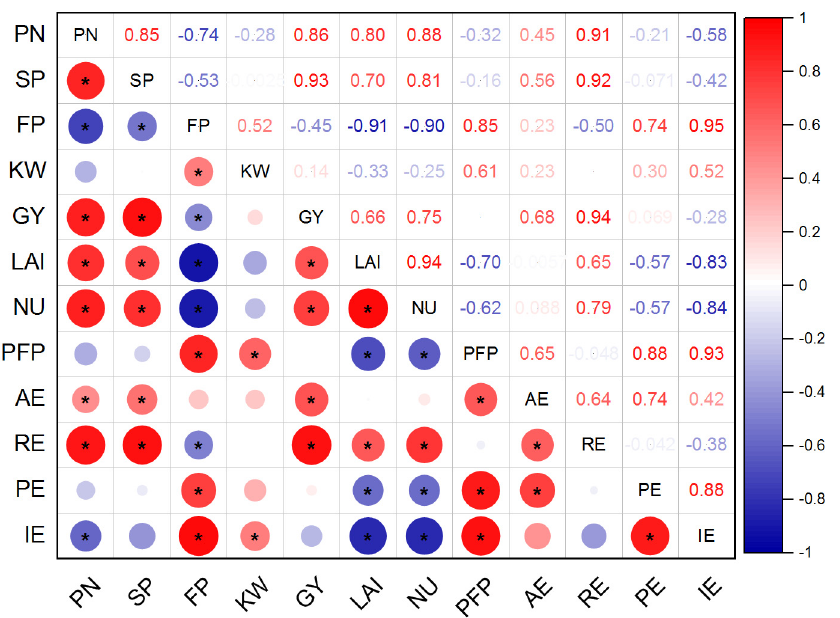
Figure 2. Correlation analysis between rice grain yield components and nitrogen use efficiency. PN, panicle number; SP, spikelets per panicle; FP, Filled kernel percentage; KW, kernel weight; GY, grain yield; LAI, leaf area index; NU, nitrogen uptake; PFP, partial factor productivity; AE, agronomic N use efficiency; RE, apparent recovery efficiency of N fertilizer; PE, physiological N use efficiency; IE, internal N use efficiency. *: Significant at the p < 0.05 level.